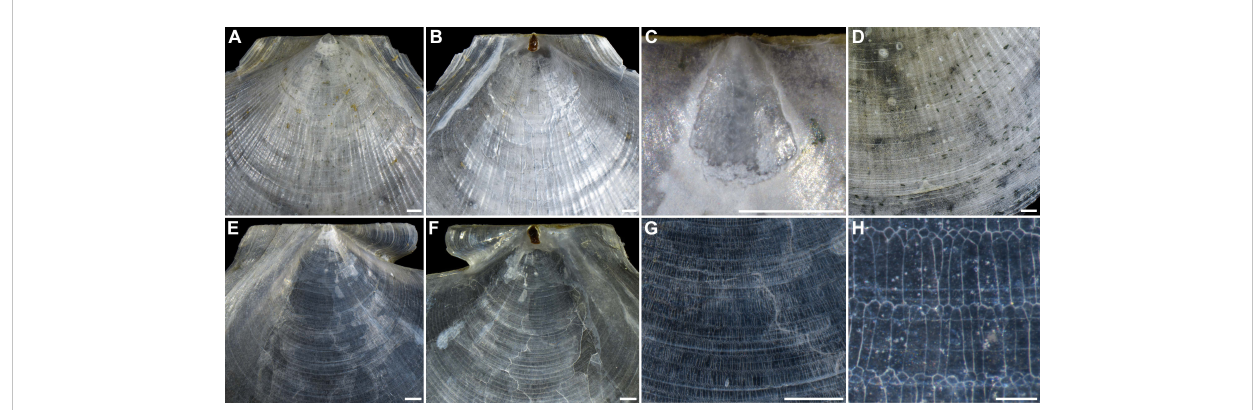
FIGURE 3 Morphological details of Catillopecten margaritatus n. sp. shells (holotype, TMBC, SCSMBC031006). (A – D) Left valve. (A) External view of auricles. (B) Internal view of auricles. (C) Umbo area of the left valve. (D) External surface commarginal undulations and fi ne radial threads. (E – H) Right valve. (E) External view of auricles. (F) Internal view of auricles. (G) Sculpture of the center. (H) Prismatic microstructure of the center. Scale bar: (A – G) , 1 mm; H, 0.1 mm.